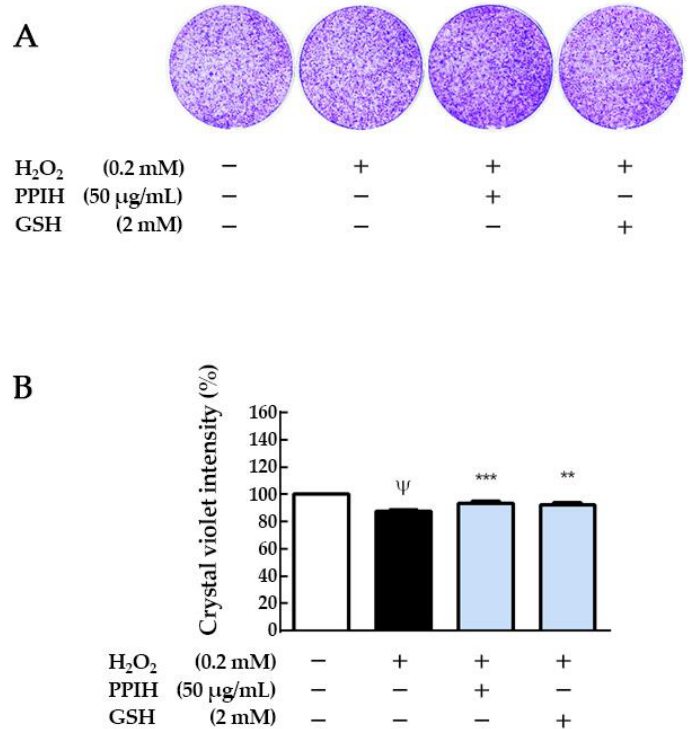
Figure 6. E ff ect of PPI and PPIH on the cell morphology of C2C12 cells. ( A ) Cell morphology. ( B ) Crystal violet intensity. C2C12 myoblasts were cultured (1 × 10 4 cells) in 2% horse serum DMEM to di ff erentiate for 6 days. After 6 days of di ff erentiation, cells were pretreated with 50 µ g / mL PPIH for 24 h and then treated with 0.2 mM H 2 O 2 for 1 h. Ψ p < 0.05 versus control (white column), ** p < 0.01 or *** p < 0.001 compared with induced group (black column). PPIH: potato protein isolate hydrolysate. GSH: